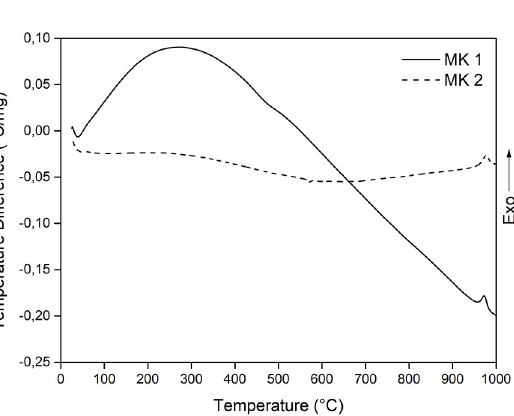
Figure 4. DTA curves of MK1 and